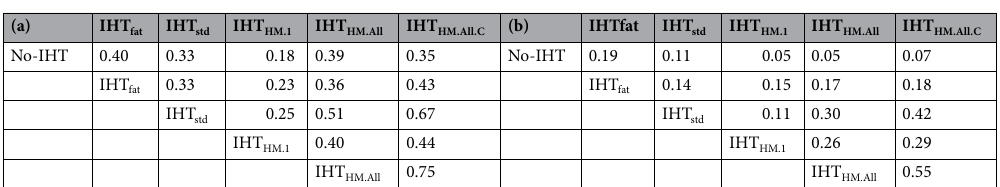
Table 3. Comparisons of the different dendrograms obtained by hierarchical clustering of the radiomics features with the 6 datasets depending on the intensity harmonization technique (IHT). ( a ) Corresponds to the Cohen’s Kappa index ranging from 0 (completely different clustering assignements) to 1 (exactly the same clustering assignements). ( b ) Corresponds to the the Baker’s gamma coefficient ranging from 0 (completely different dendrograms) to 1 (exactly the same two